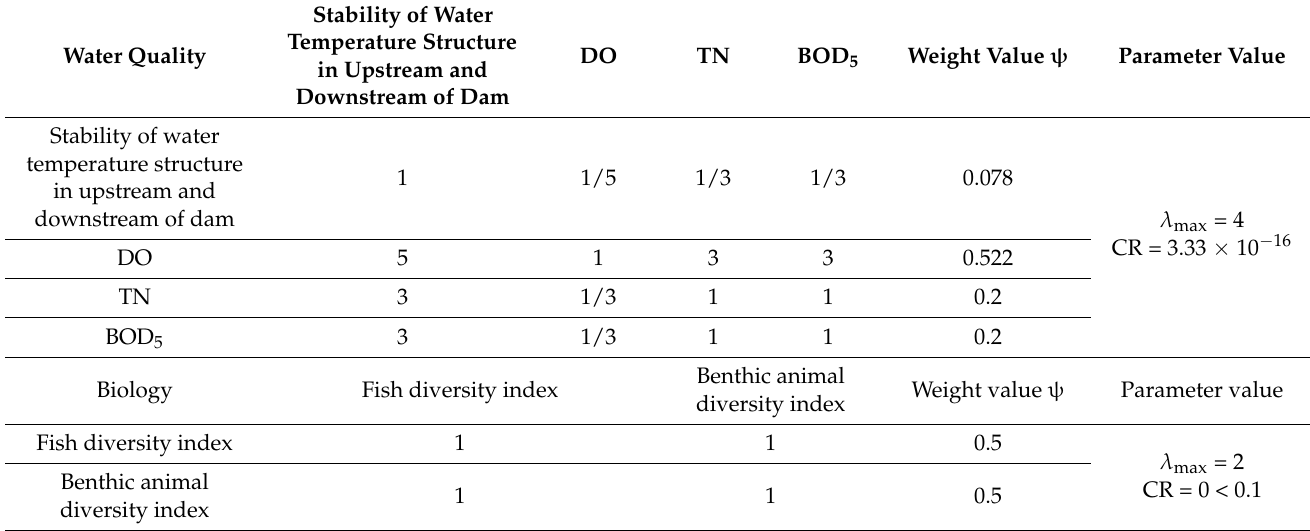
Table 3. Judgment matrix and weight of water quality and biological characteristics of Tufang River (2018) by